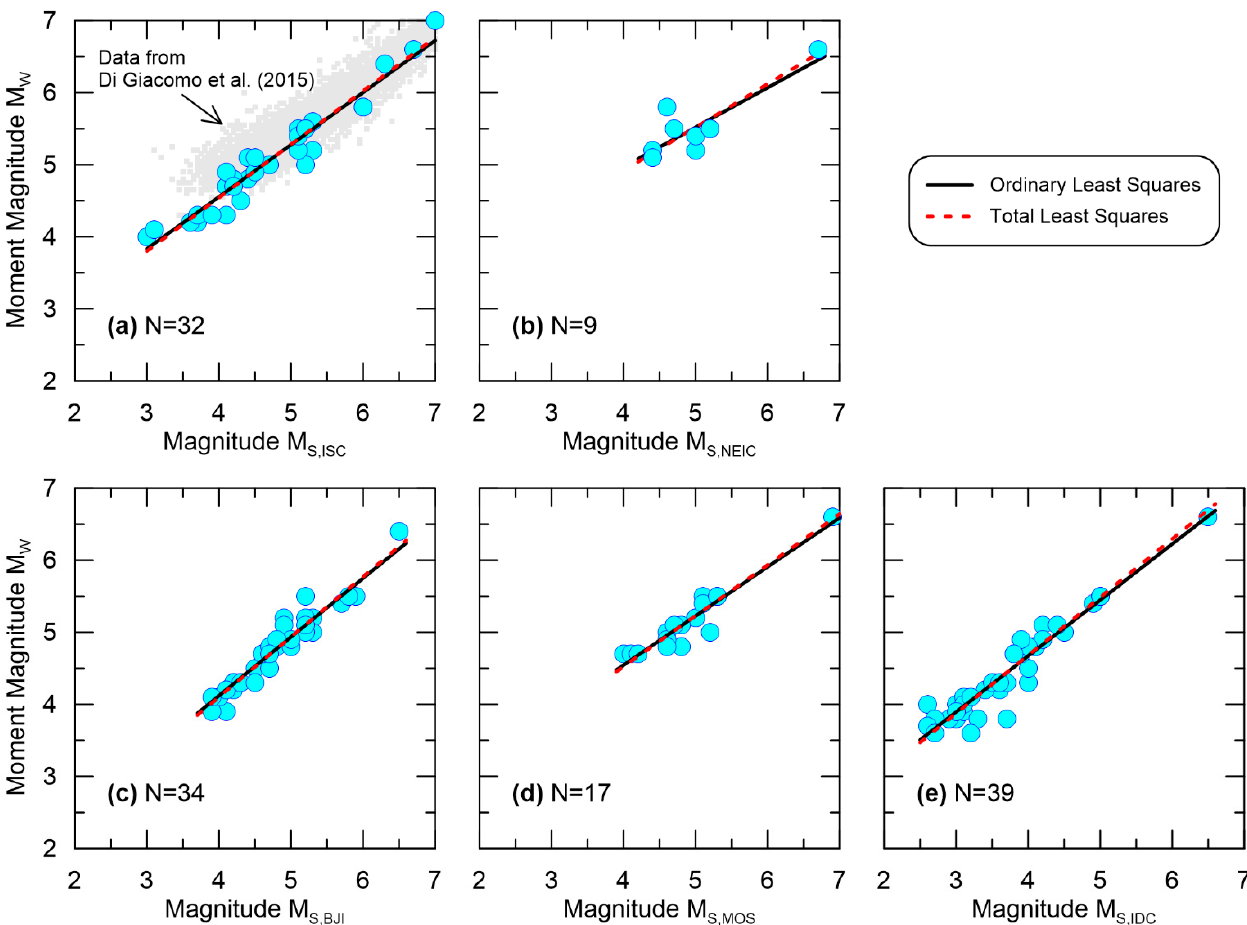
Figure 2. Relationships between M w against M S from ( a ) ISC, ( b ) NEIC, ( c ) BJI, ( d ) MOS, and ( e ) IDC. The solid and dashed lines represent the regression type as indicated in the graph. N is the number of data points used for regression. Data by Di Giacomo et al. (2015) from a larger earthquake compilation related to M w versus M S.ISC is shown in gray symbols in the background for comparison [19].